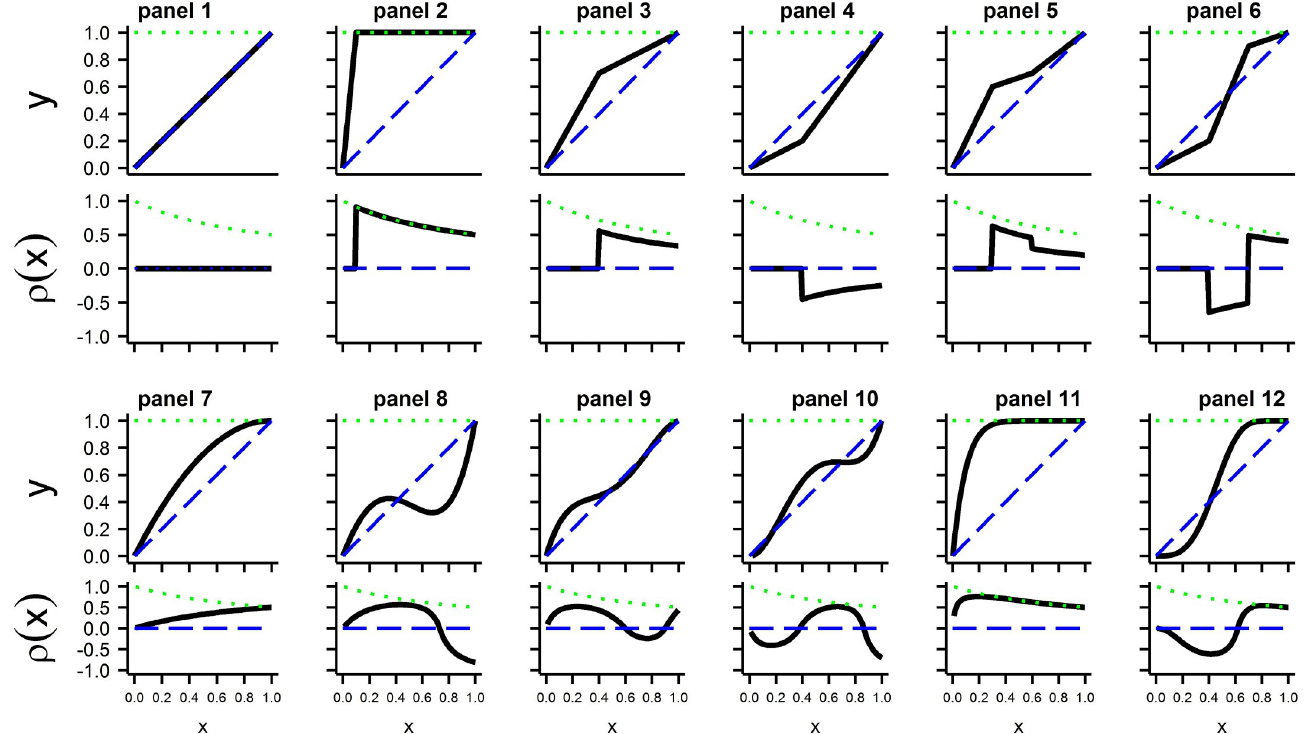
Fig 2. Each panel contains the hypoxia plot on top and the matching regulation profile below. The blue dashed line is the curve for a non-regulator and the green dotted line is the curve for a perfect regulator. The 12 panels contain the following models: (1) S1 (a non-regulator), (2) S2 with P t = 0.1, (3) S3 with P t = 0.4, V t = 0.7, (4) S3 with P t = 0.4, V t = 0.2, (5) S4 with P t1 = 0.3, V t1 = 0.6, P t2 = 0.6, V t2 = 0.7, (6) S4 with P t1 = 0.4, V t1 = 0.2, P t2 = 0.7, V t2 = 0.9, (7) Polynomial with b 0 = 0, b 1 = 2, b 2 = -0.99, b 3 = -0.01, b 4 = 0, (8) Polynomial with b 0 = 0, b 1 = 2.6, b 2 = -4, b 3 = -1.1, b 4 = 3.5, (9) Polynomial with b 0 = 0, b 1 = 3.333, b 2 = -10.222, b 3 = 14.222, b 4 = -6.333, (10) Polynomial with b 0 = 0, b 1 = 0.1, b 2 = 9.2, b 3 = -17.5, b 4 = 9.4, (11) C2 with P p = 0.1, (12) C3 with P p = 0.5, V p = 0.3.